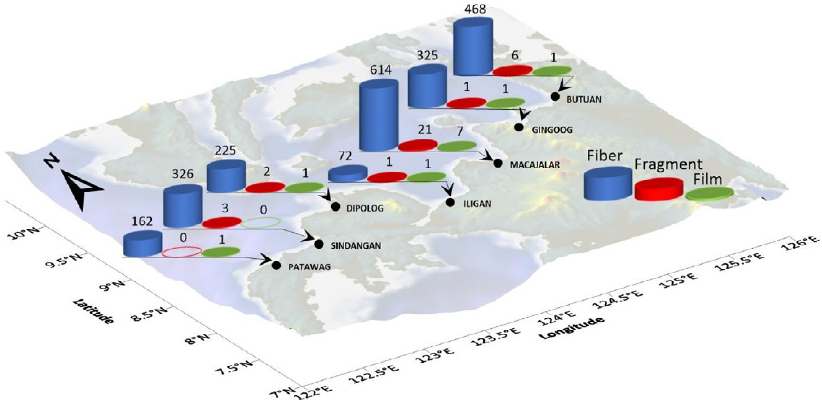
Fig. 3: Spatial distribution of the total microplastics classified into fiber, fragment, and film